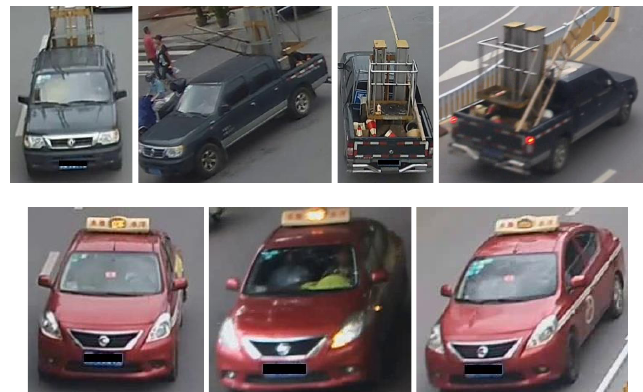
Figure 1. ( Top row ) Large intra-class differences, i.e., same vehicle looking different from distinct perspectives; ( bottom row ) small inter-class similarities, i.e., different vehicles looking very